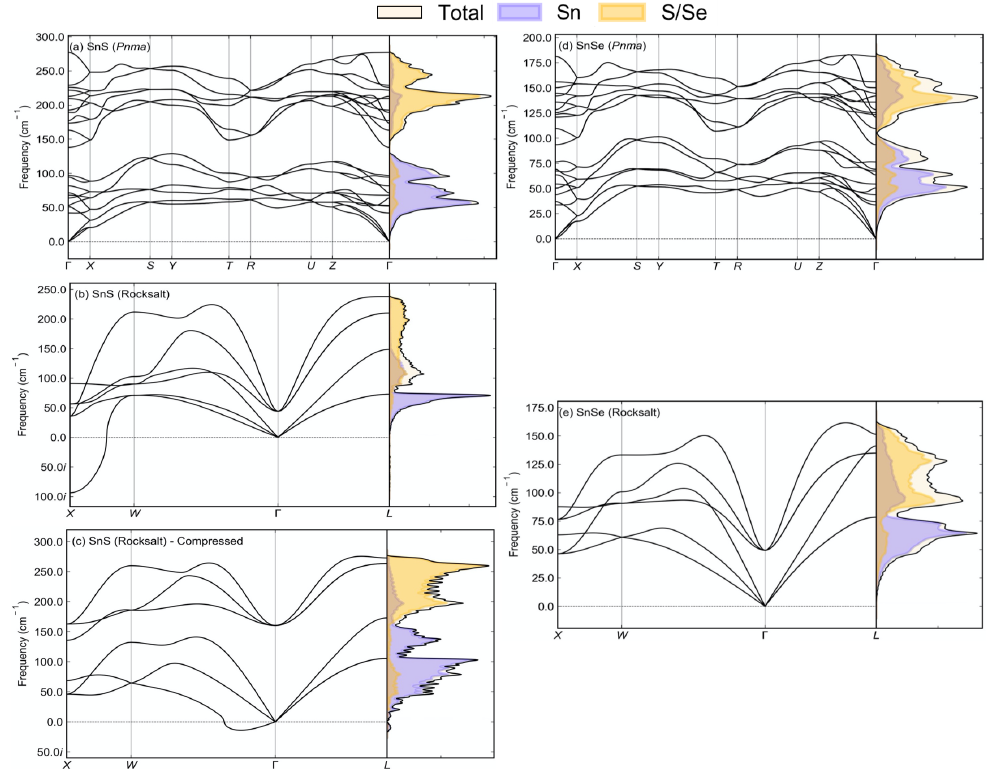
Figure 2. Calculated phonon dispersion and density of states (DoS) of Pnma SnS ( a ), equilibrium and compressed rocksalt SnS ( b , c ), Pnma SnSe ( d ), and rocksalt SnSe ( e ). On each DoS plot, the total DoS is shown in black and projections onto the Sn and S/Se atoms are shown as blue and orange shaded